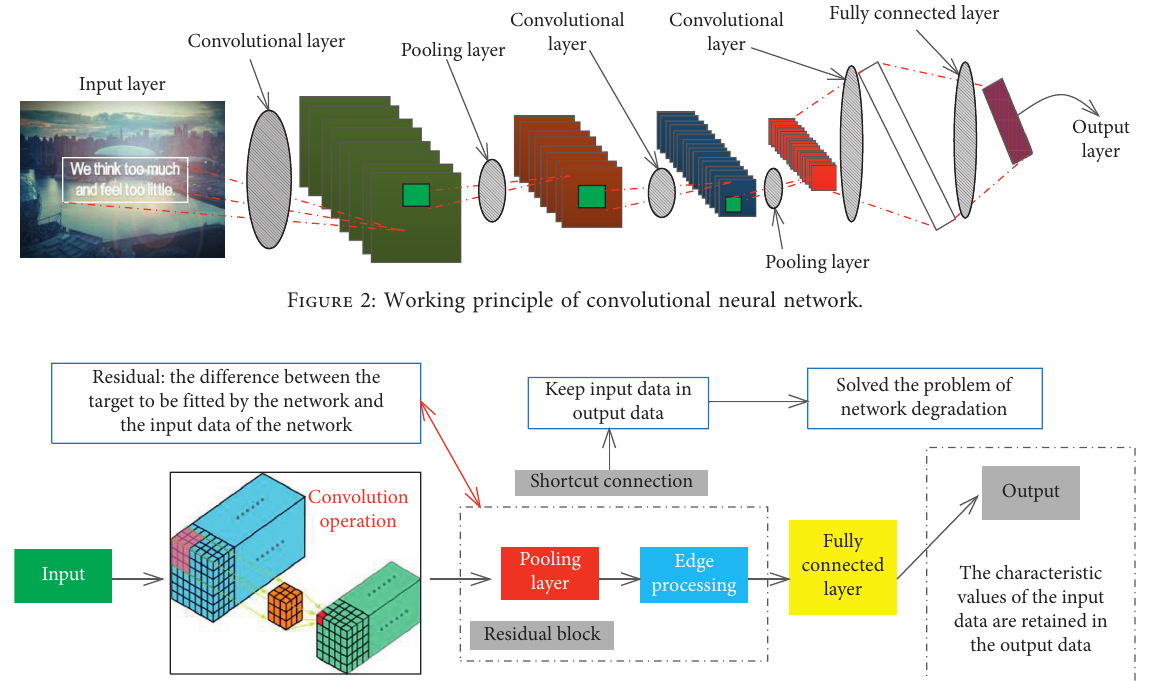
Figure 3: Block diagram of residual network structure.